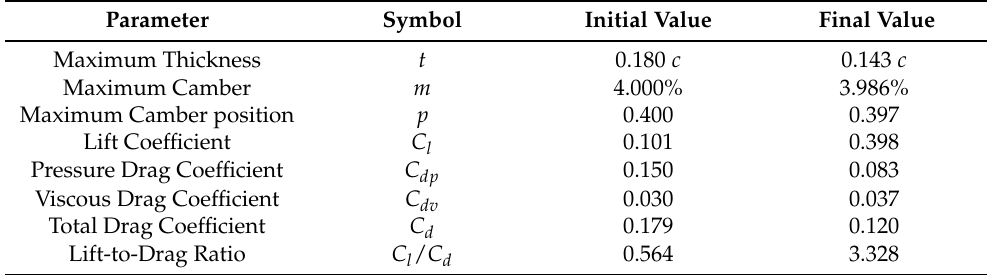
Table 4. The initial and final values of the components that determine the airfoil geometry and aerodynamic coefficients were optimized to achieve maximum lift and minimum drag